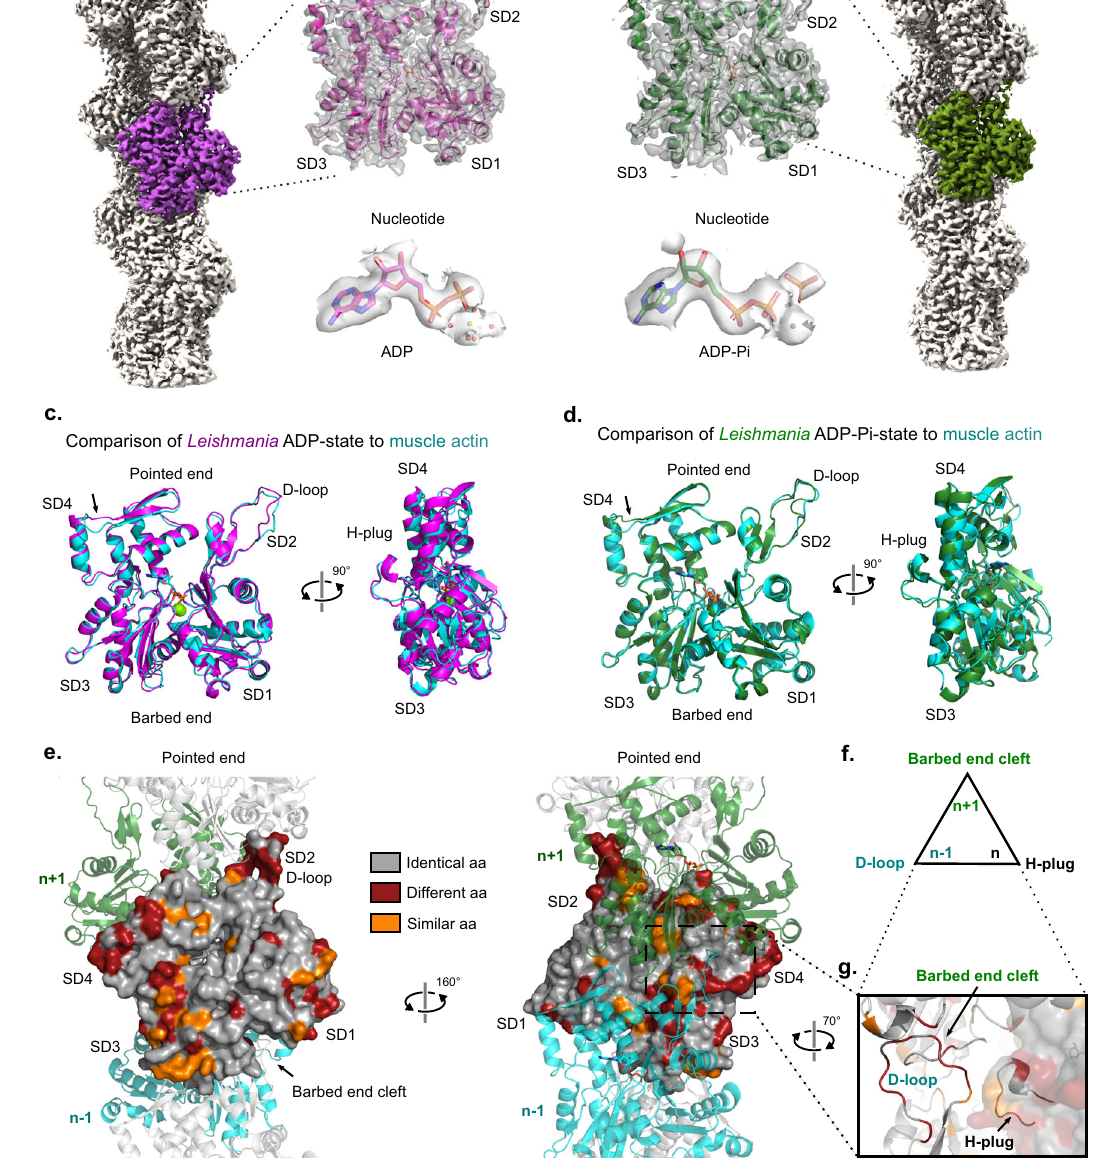
Fig. 3 Structures of Leishmania ADP- and ADP-Pi-actin fi laments. a A cryo-EM map of Leishmania major ADP-actin fi lament. The overall model, ADP and waters modeled in the fl attened density around the Mg 2 + ion are shown. b A cryo-EM map of L. major ADP-Pi-actin fi lament. The overall model, ADP, Pi, and Mg 2 + are shown. c Superimposition of L. major ADP-actin (magenta) to vertebrate ADP-actin (cyan, PDB ID: 6DJO) subunit. The pointed end tips of actin subdomain 4 (indicated with an arrow) follow slightly different paths in LmActin and vertebrate muscle actin. d Superimposition of L. major ADP-Pi- actin (green) to vertebrate ADP-Pi actin (cyan, PDB ID: 6DJN) subunits. The ADP-Pi conformations in L. major and vertebrate actins are nearly identical to each other. e Positions of residues that are not conserved between rabbit muscle and L. major actins are highlighted in the structure surface presentation. Gray color indicates identical, orange similar, and red different amino acids in the corresponding positions between the two actins (see Supplementary Fig. 3b). Neighboring subunits ( n -1 and n + 1) are shown in cyan and green cartoon representations. Note that the non-conserved residues are concentrated at the regions important for inter- and intra-strand contacts, with the exception of the barbed end groove that exhibits high conservation. f Schematic presentation of the regions that are critical for the formation of an actin fi lament core. g D-loop, together with barbed end groove and H-plug from two neighboring subunits form the core of the fi lament. Red and orange colors depict sequence conservation as described in panel e